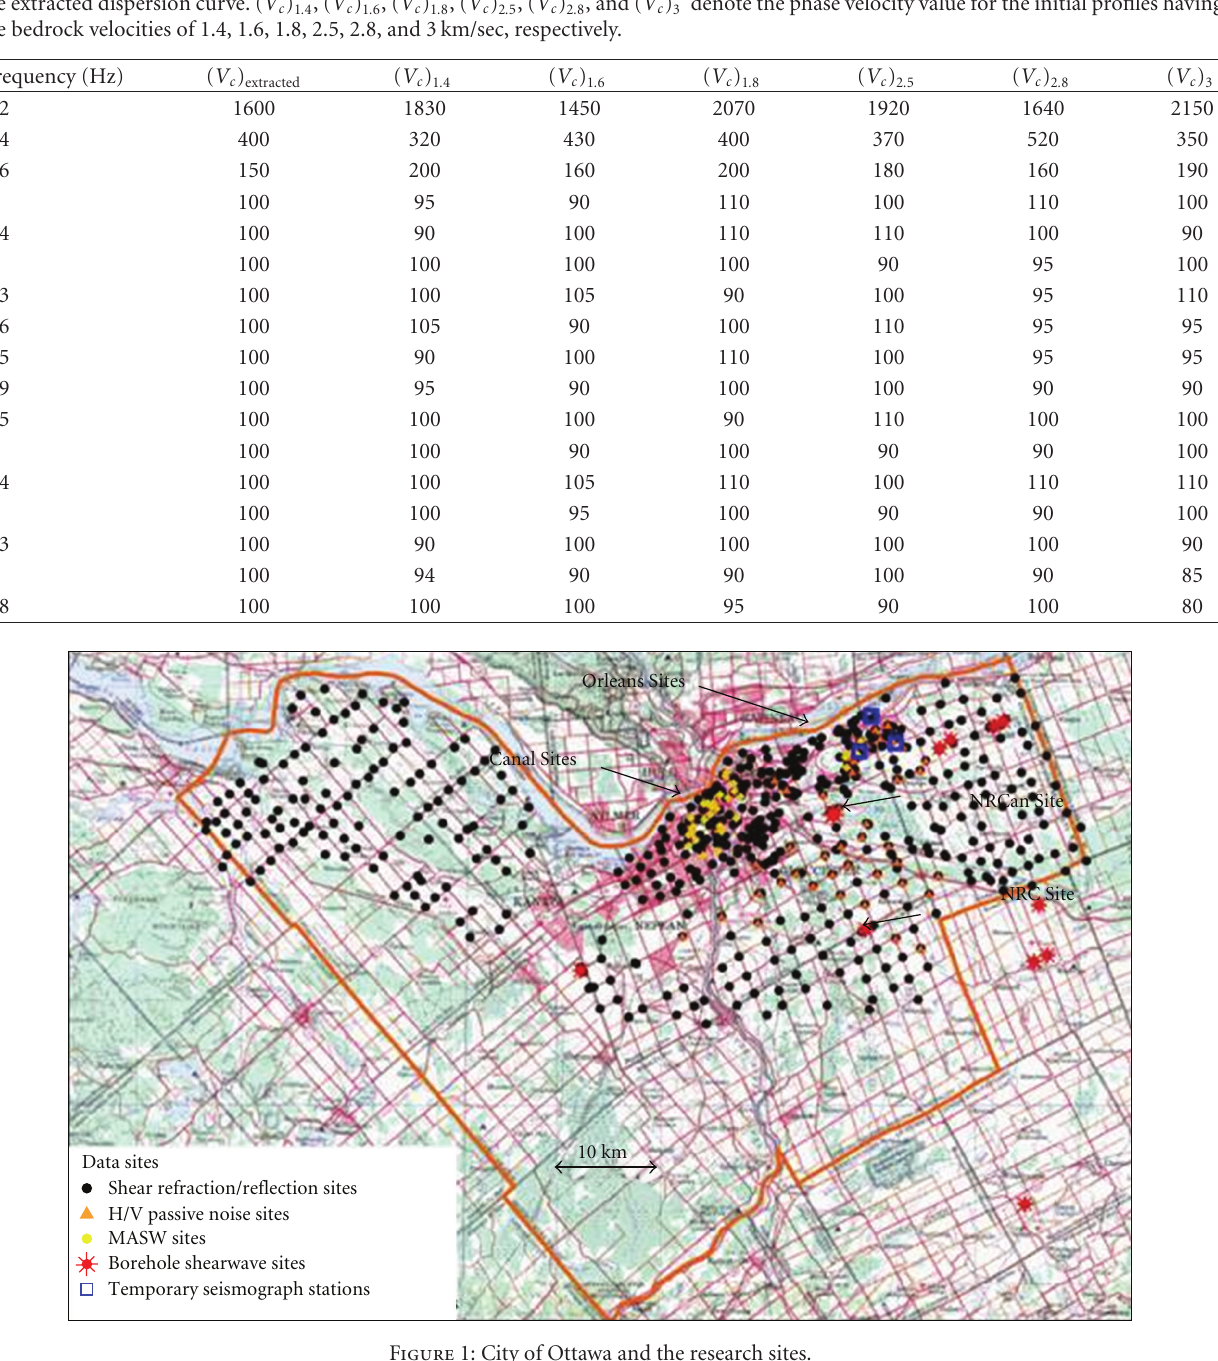
is the phase velocity of extracted